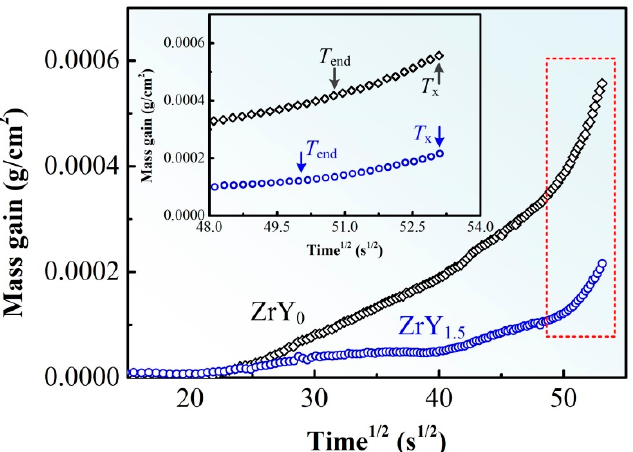
Figure 5. Parabolic plots of the mass-gain data for the ZrY 0 BMG and ZrY 1.5 BMG under the heating rate of 10 K/min.